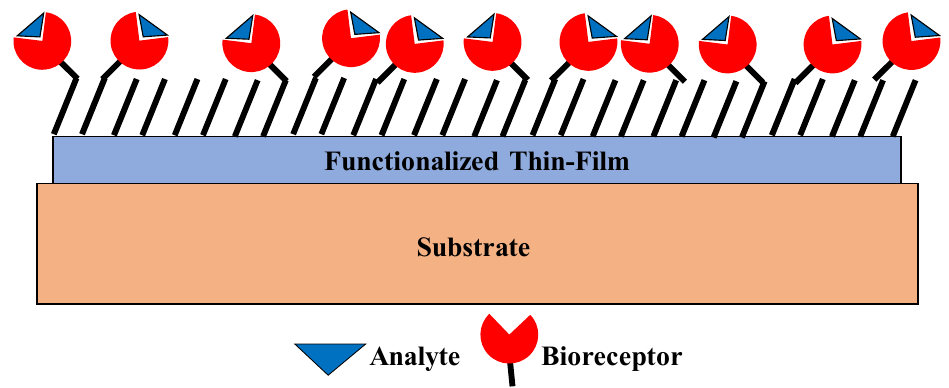
Figure 3. Working principle of thin-film-based biosensors. The thin films are functionalized with appropriate bioreceptors to realize specific capture of analyte molecules. This capture is then measured to indirectly quantify the analyte concentration.